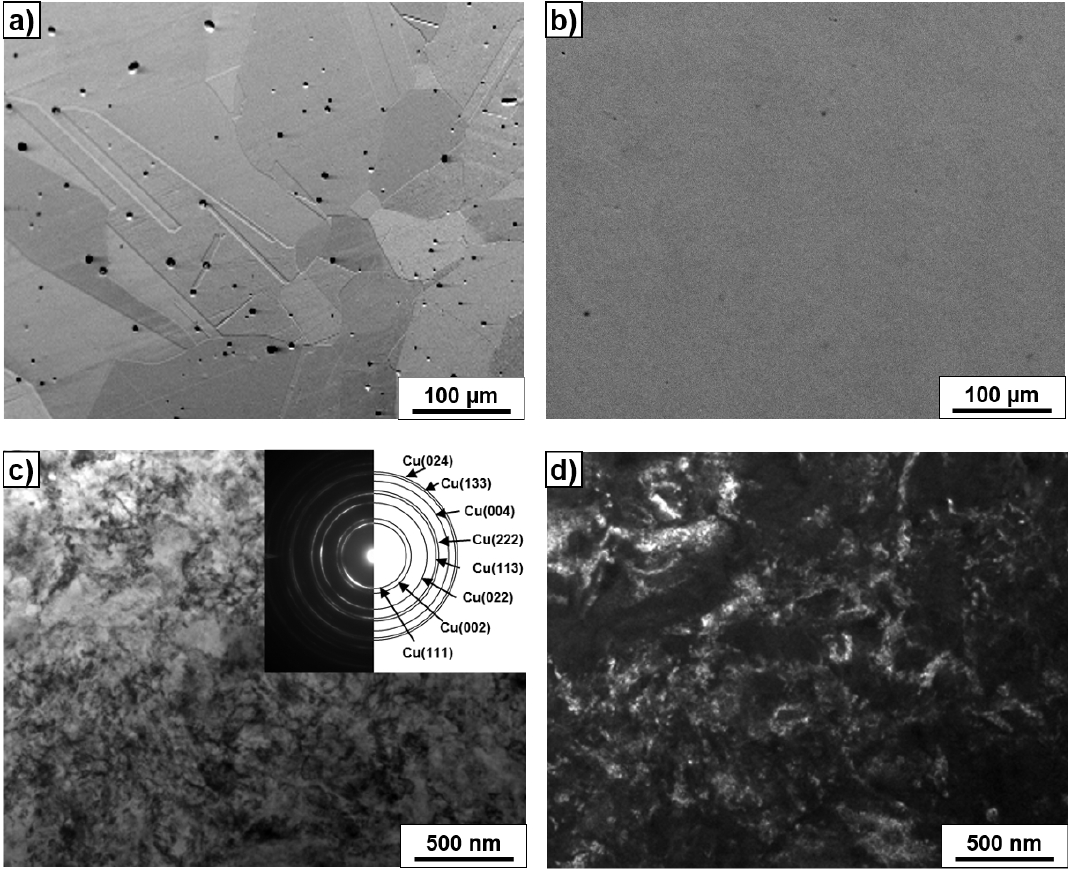
Figure 2. SEM images of the Cu–14 wt% Sn alloy after annealing at 500 °C for 894 h ( a ) and following HPT deformation ( b ). Bright-field ( c ) and dark-field ( d ) TEM images of the microstructure of the HPT-deformed Cu–14 wt% Sn alloy, pre-annealed at 500 °C for 894 h. The selected area electron diffraction (SAED) pattern is shown as the insert in ( c ).